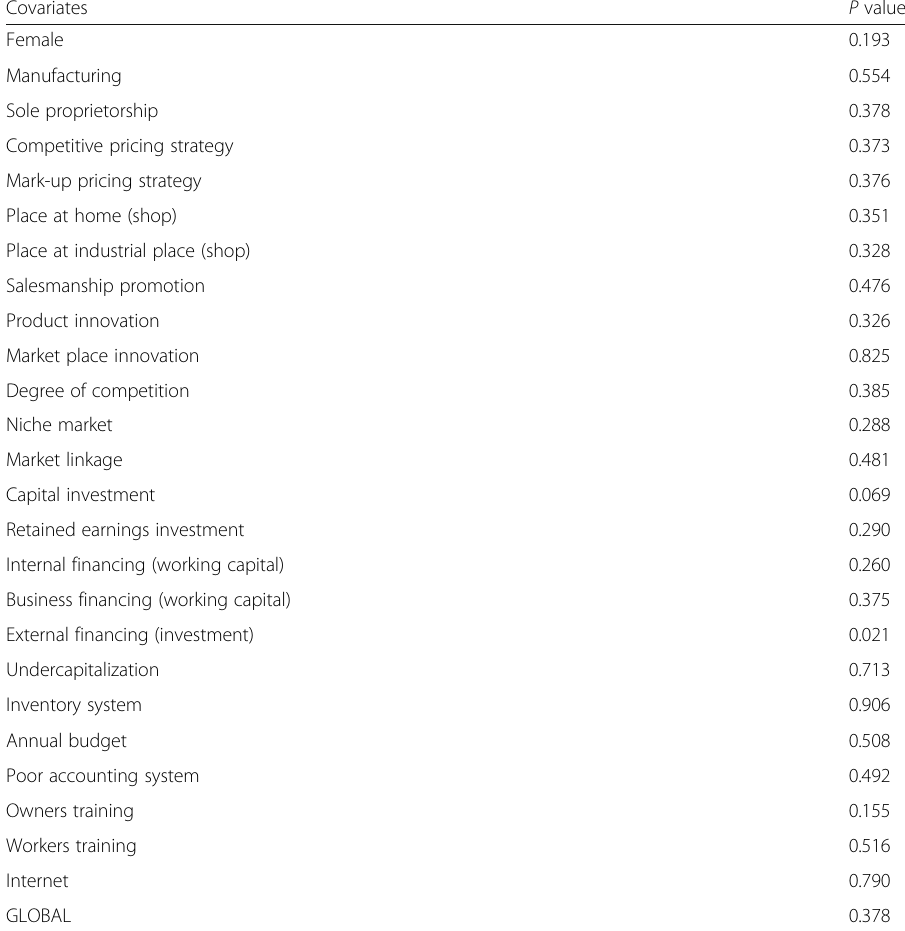
Table 6 Proportional hazard test using chi-square statistics: Cox model analysis — model